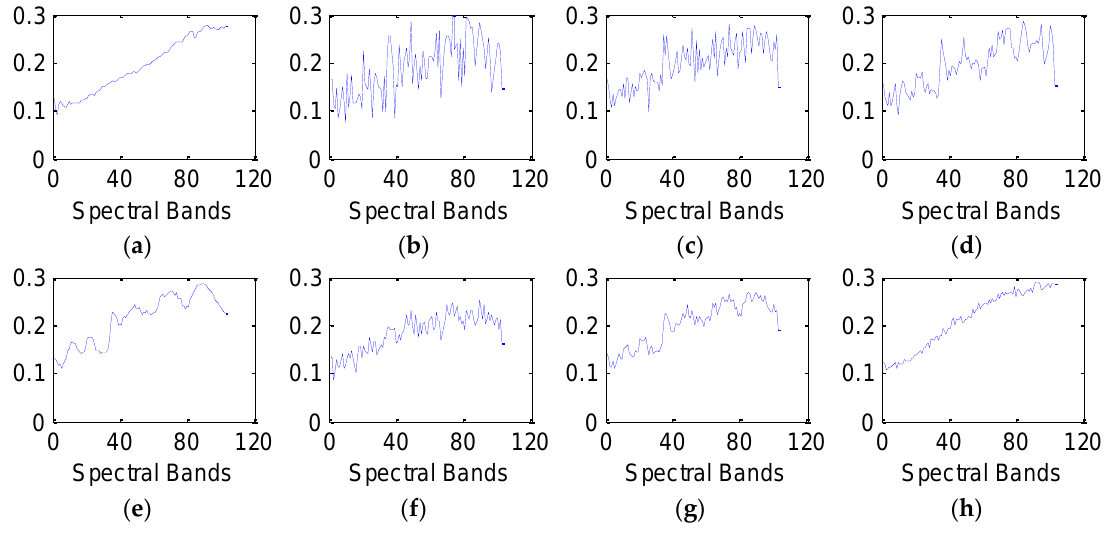
Figure 13. Spectral reflectance curves before and after denoising at pixel (399, 290): ( a ) clean HSI; ( b ) KSVD; ( c ) BM3D; ( d ) ANLM3D; ( e ) BM4D; ( f ) LRMR; ( g ) DDL3+FT; ( h ) Our method.